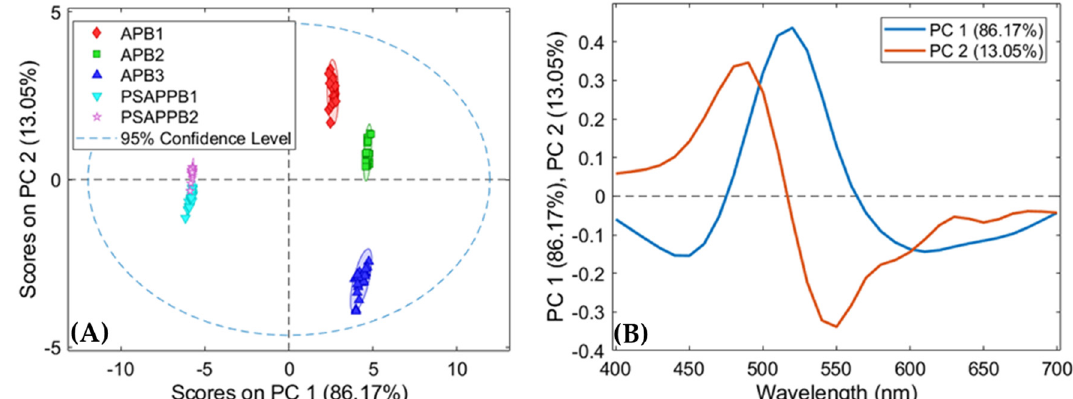
Figure 7. Score plot ( A ) of principal component analysis and loadings ( B ) of the reflectance data of the yellow pigments.